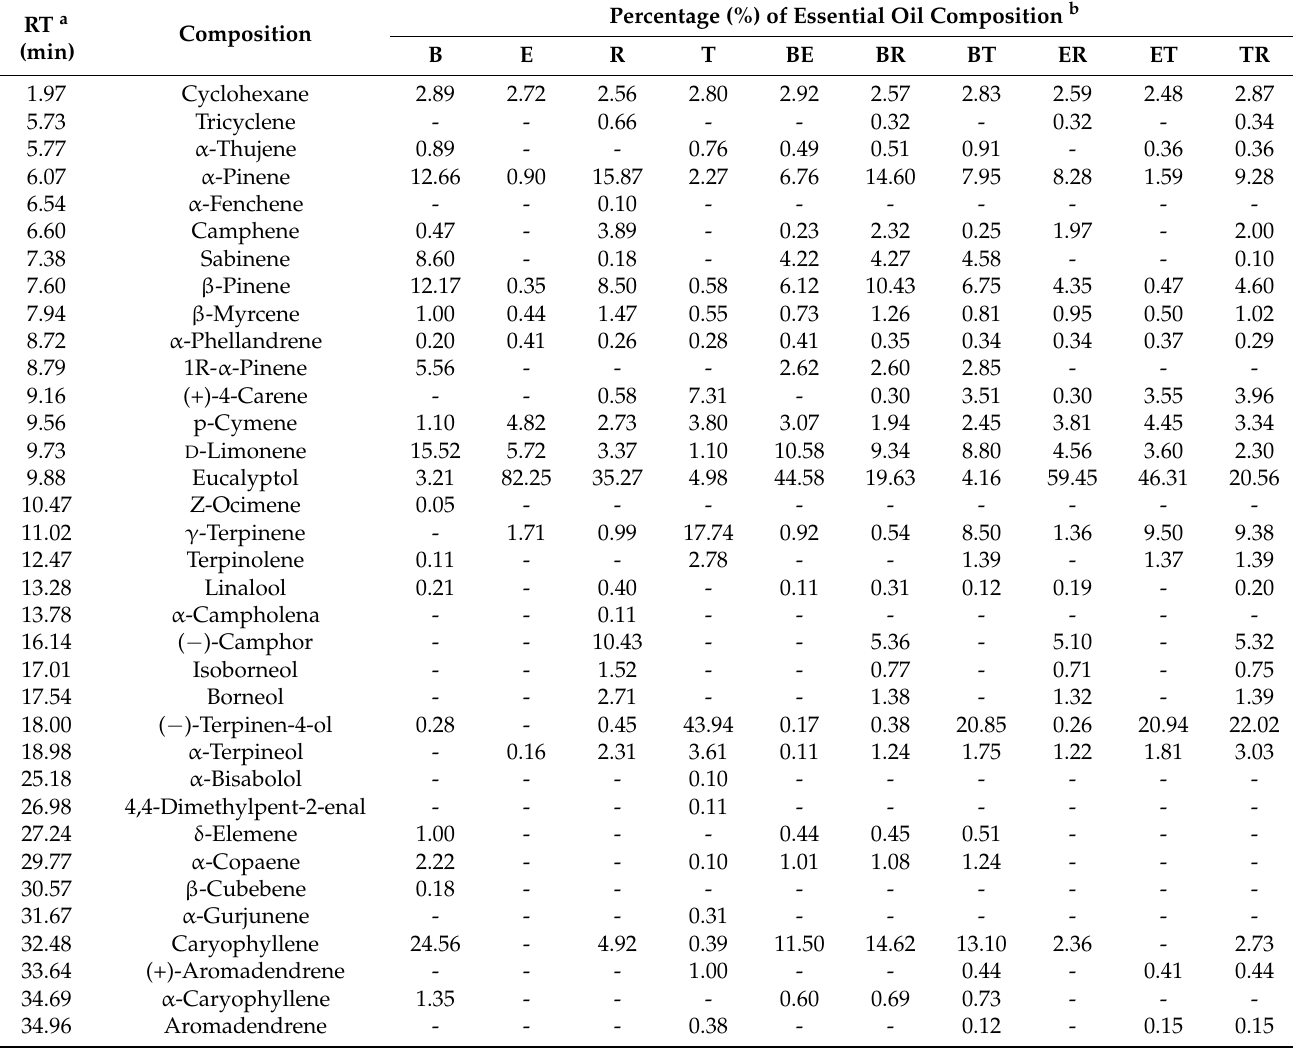
Table 1. Chemical constituents of pure and mixed essential oils analysis by